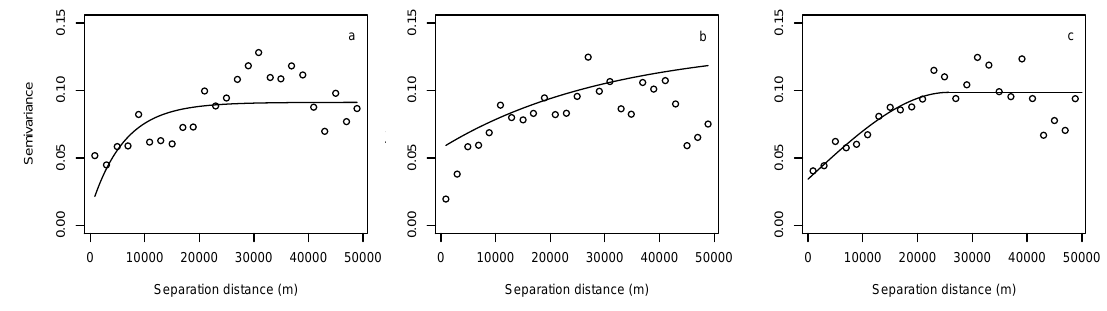
Figure 2. Experimental semivariograms of soil N ( a ), P ( b ), and K ( c ) stocks. Table 2. Models and their parameters fitted for the semivariograms of soil N, P, and K stocks within 0–60